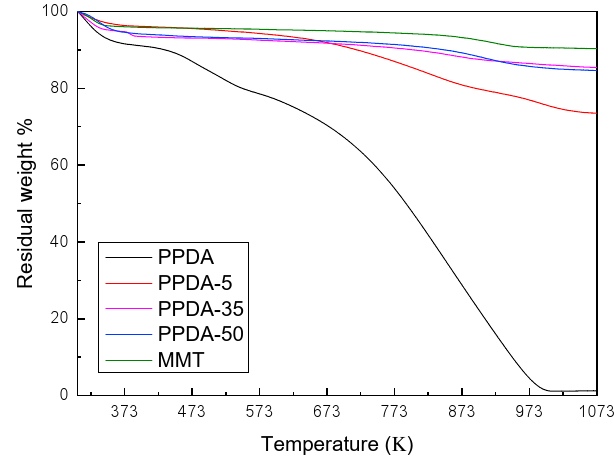
Figure 1. TGA curves of pristine MMT, PPDA and their composites.